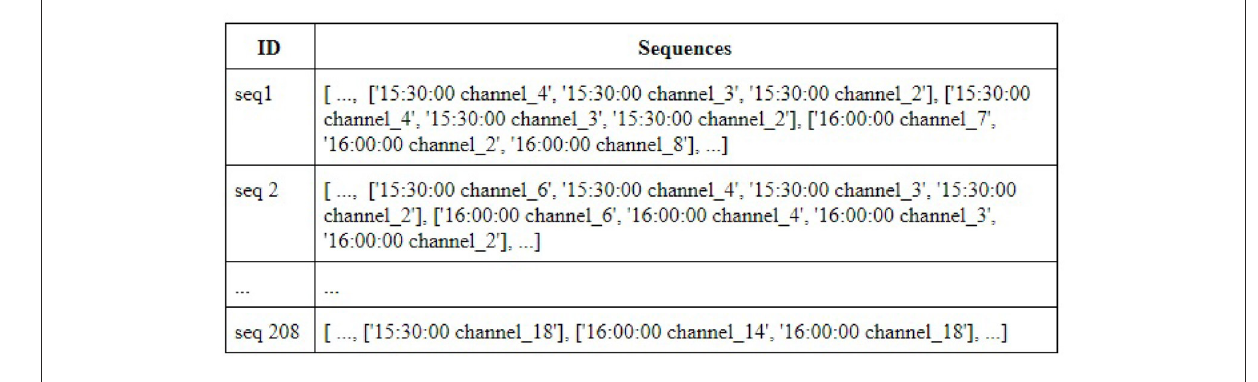
FIGURE4 Sequences for House 2.